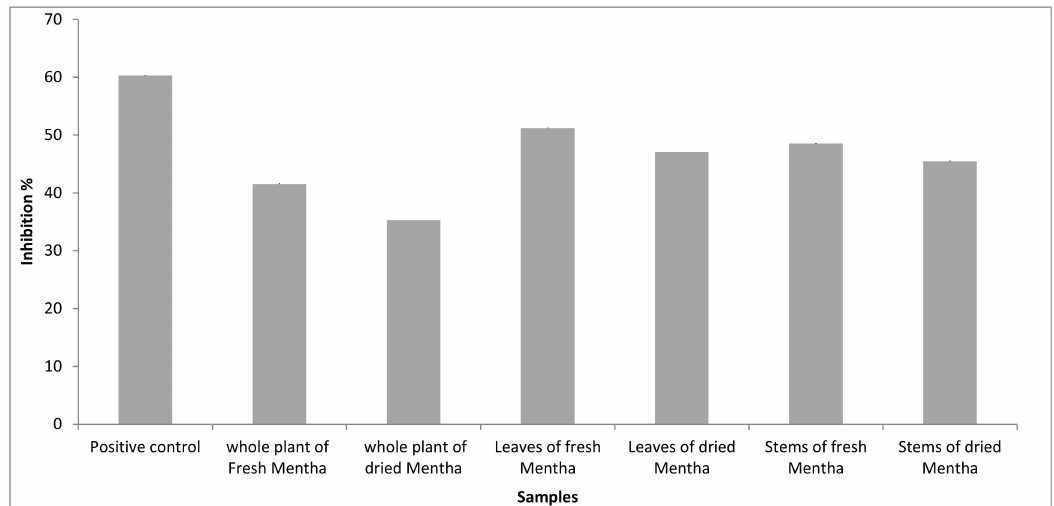
Figure 4. Antifungal activity of volatile oils of M. suaveolens L.